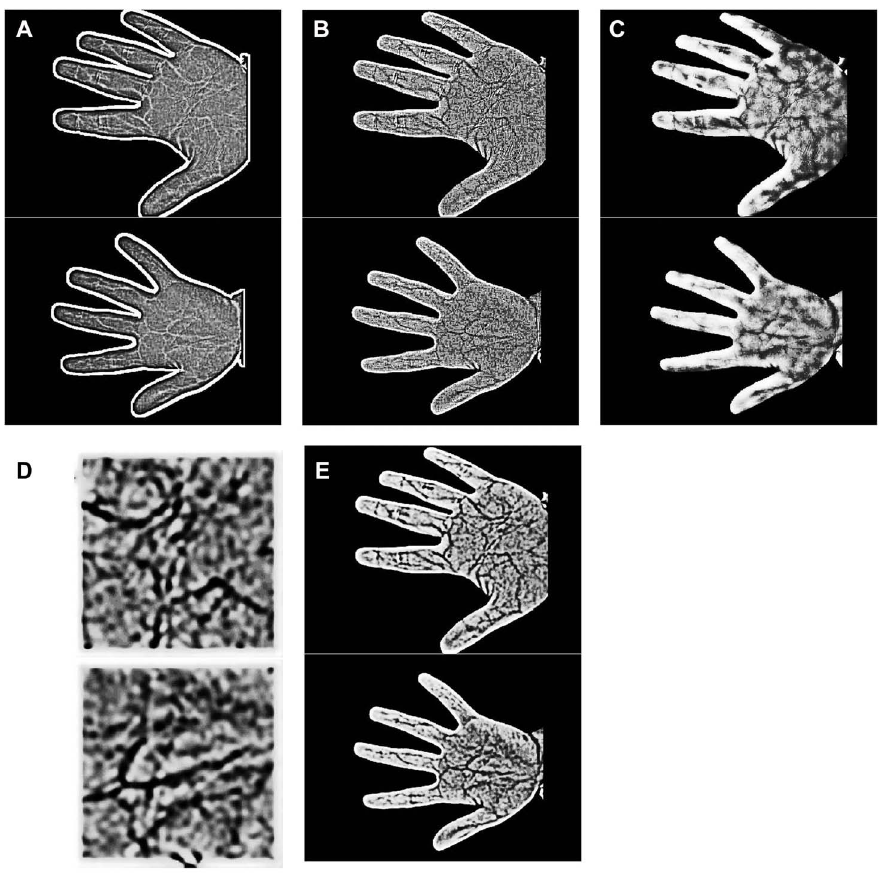
Figure 12. Examples of five preprocessing methods. (a) Weber illumination normalization; (b) Retinex based illumination normalization; (c) Background estimation; (d) Our method on ROI; (e) Our method.